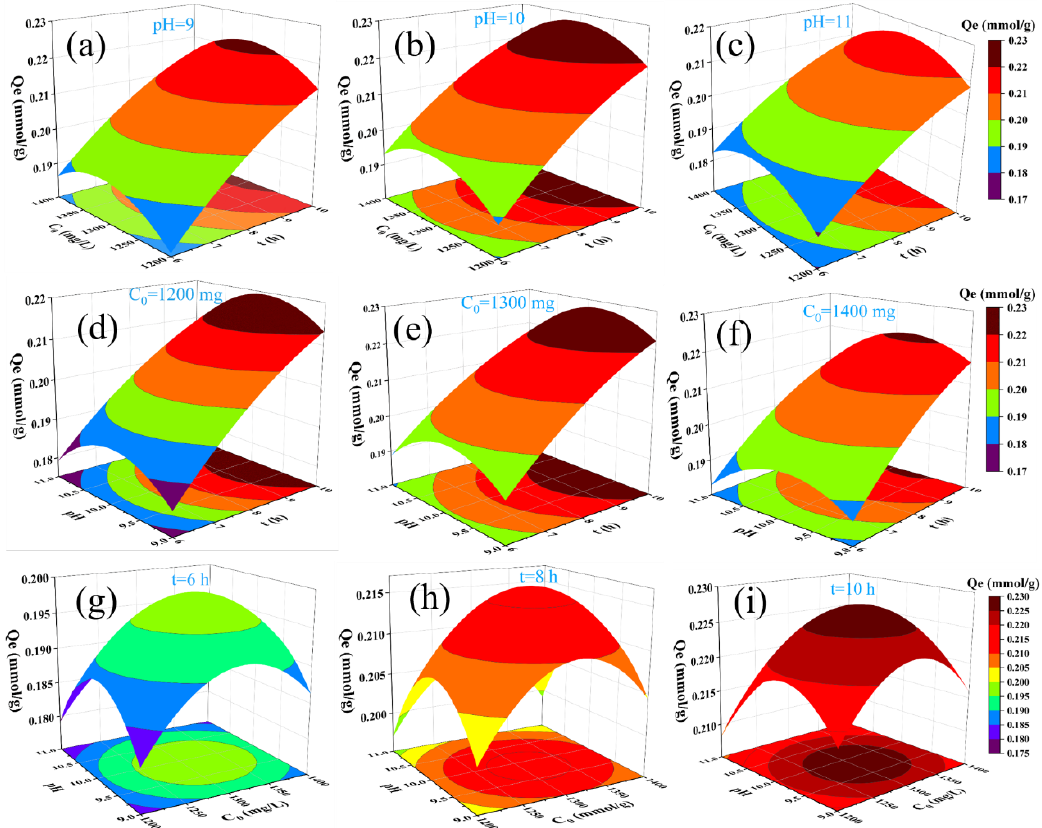
Figure 5. Binary interactions of ( a ) t and C 0 (pH = 9); ( b ) t and C 0 (pH = 10); ( c ) t and C 0 (pH = 11); ( d ) pH and t (C 0 = 1200 mg); ( e ) pH and t (C 0 = 1300 mg); ( f ) pH and t (C 0 = 1400 mg); ( g ) pH and C 0 (t = 6 h); ( h ) pH and C 0 (t = 8 h); and ( i ) pH and C 0 (t = 10 h) on the adsorption capacity of boric acid.